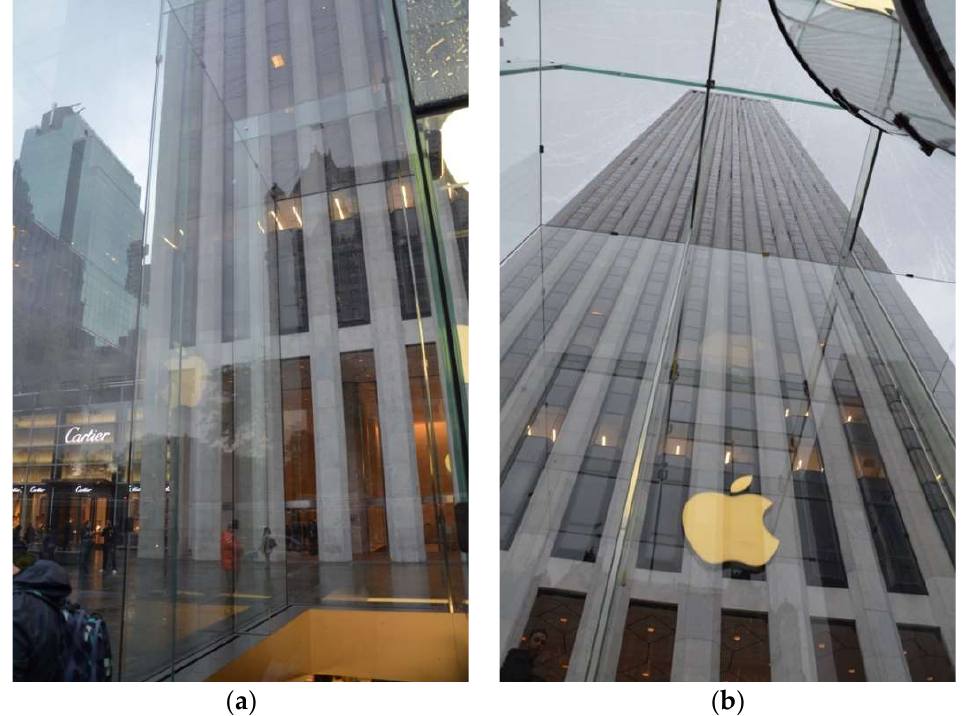
Figure 1. Self-supporting architectural glazing at the Apple Fifth Avenue store in Manhattan, New York: ( a ) transparent walls with glass fins and façade panels; ( b ) roof skylight supported by load- bearing glass beams.